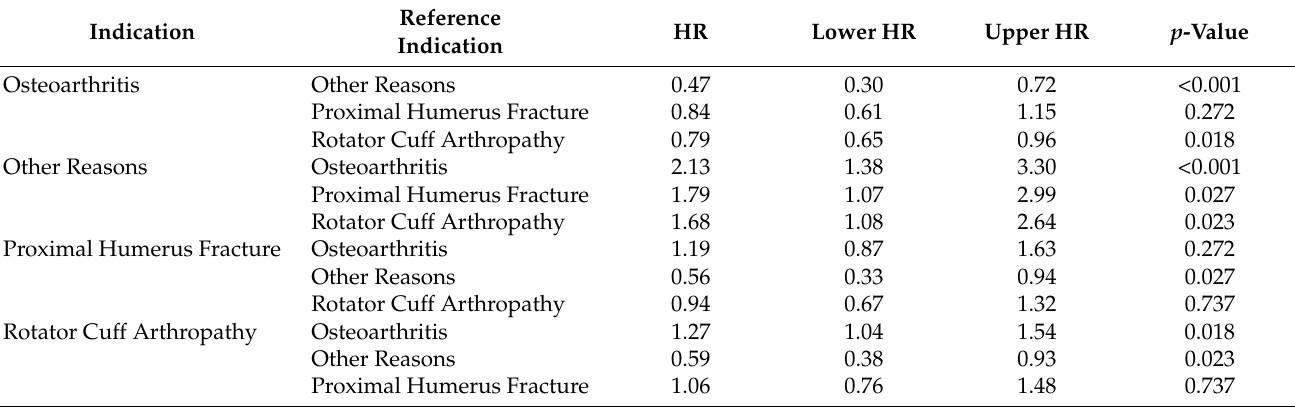
Figure 2. Revision rates after shoulder arthroplasty for proximal humerus fracture. The unrevised fraction of patients undergoing hemiarthroplasty is shown in red, and the unrevised fraction of pa- tients undergoing total shoulder arthroplasty is illustrated in blue.